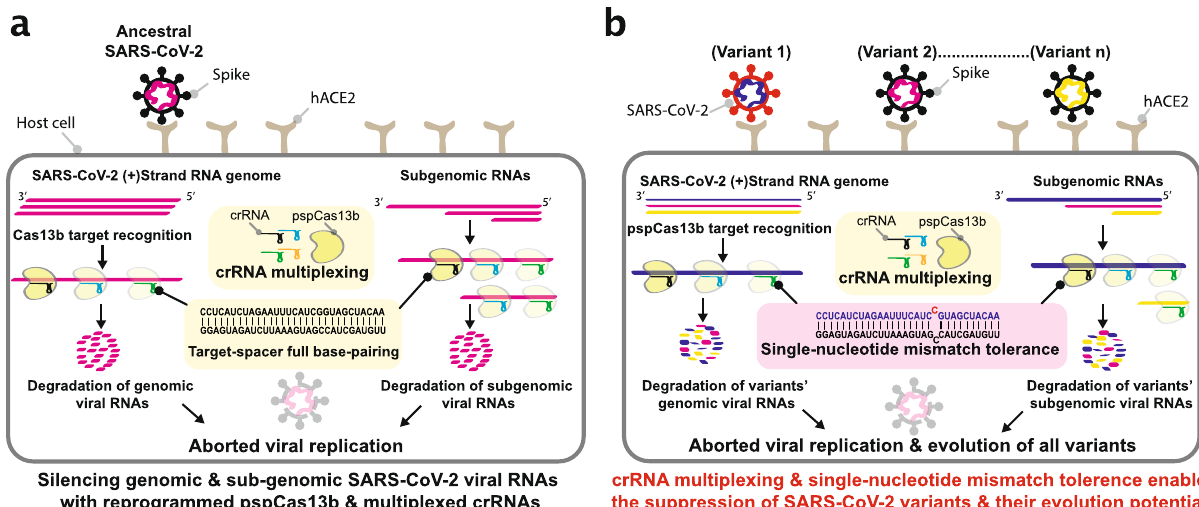
Fig. 7 Schematic depiction of pspCas13b-mediated suppression of SARS-CoV-2 variants and their evolution through crRNA multiplexing and single- nucleotide mismatch tolerance. a crRNA multiplexing enables simultaneous targeting of several genomic and sub-genomic RNA locations, which limits the probability of poor silencing due to target inaccessibility (e.g. RNA folding, interaction with RNA-binding proteins in vivo). The spacer of pspCas13b mediates sequence-speci fi c target recognition through complete base-pairing with the targeted sequence, followed by nuclease activation and target degradation. The silencing of viral RNAs alters the integrity of the viral genome, suppresses sub-genomic RNA-dependent viral protein translation, and the assembly of replication-competent viral particles within infected mammalian cells. This viral RNA targeting approach aborts viral replication cycles and inhibits the infectivity of SARS-CoV-2 virus. b The error-prone RdRP creates viral polymorphisms (or variants) through the incorporation of single- nucleotide indels, and together with host (immune system) and environmental (antiviral therapies) positive pressures, result in the emergence of new strains with higher infectivity, pathogenicity, and therapy resistance. Unlike other antiviral therapeutics (e.g. antibodies-based approaches 7,8,11,17,18 ), pspCas13b target af fi nity remains unaffected when a single-nucleotide indel occurs at the target site, enabling a single crRNA to be effective against wild type and mutant strains. Thus, pspCas13b mismatch tolerance and crRNA multiplexing approaches can suppress all variants and their viral evolution